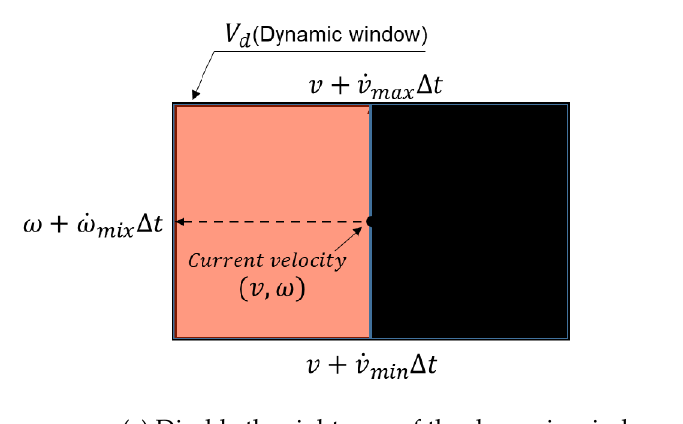
Figure 6. Modified dynamic window.